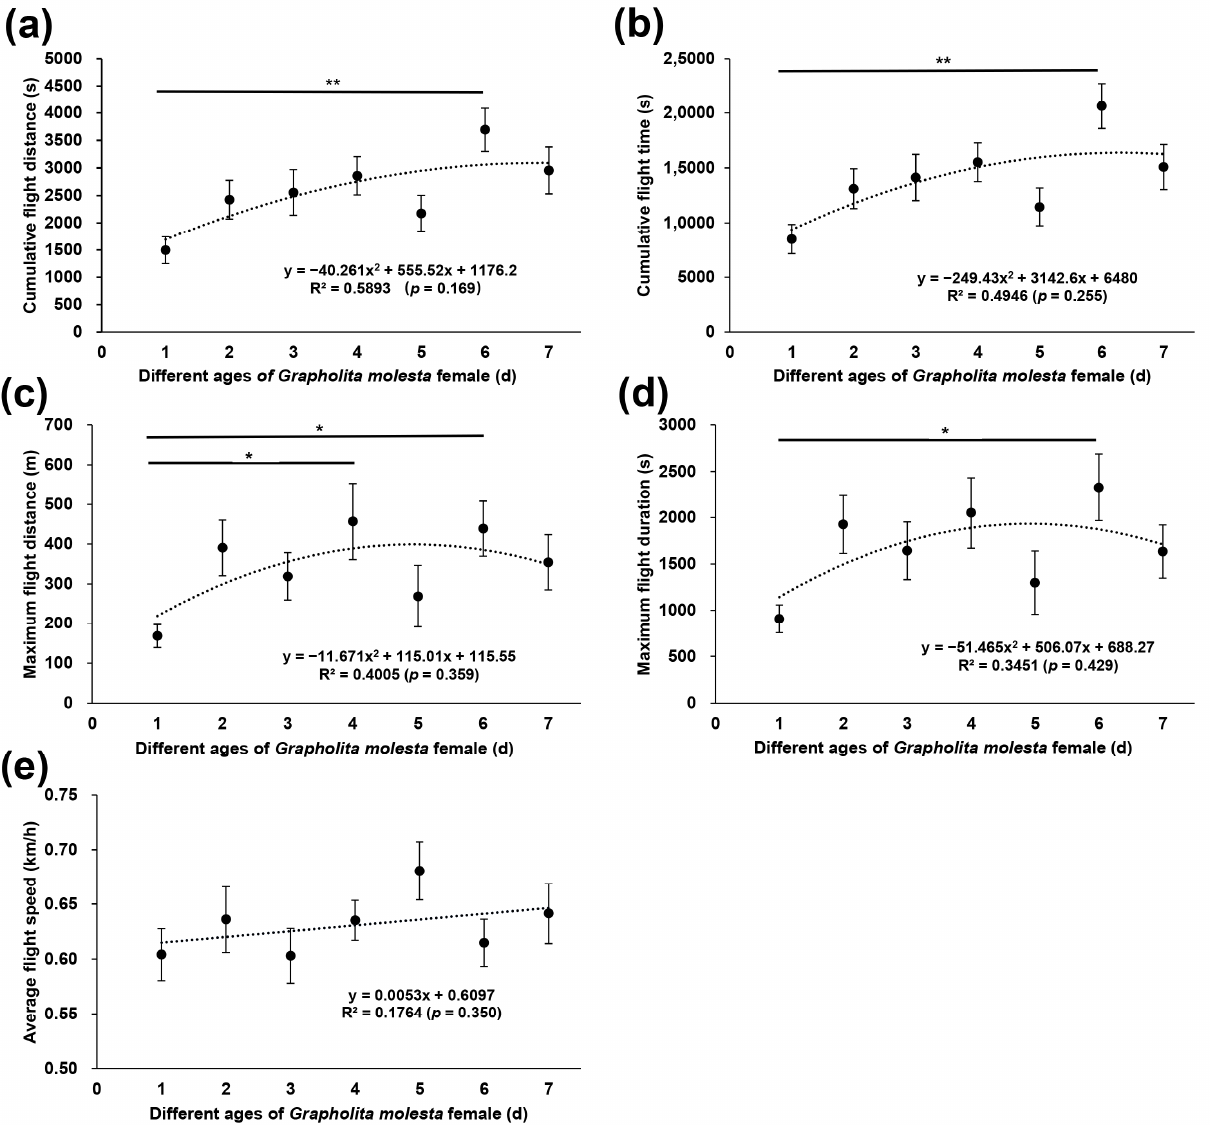
Figure 4. The cumulative flight distance ( a ), cumulative flight time ( b ), maximum flight distance ( c ), maximum flight duration ( d ), and average flight speed ( e ) of Grapholita molesta females of different age. The data are shown as the mean ± standard error. **, significant difference at p < 0.01; *, significant difference at p < 0.05.